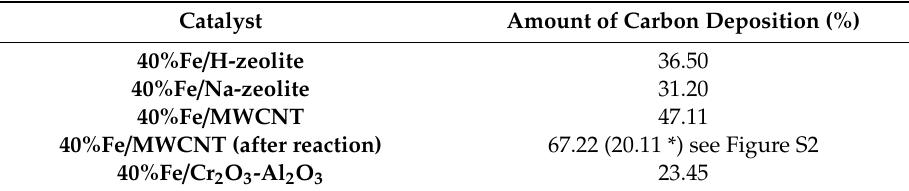
Table 2. The amount of carbon deposition on iron catalysts.